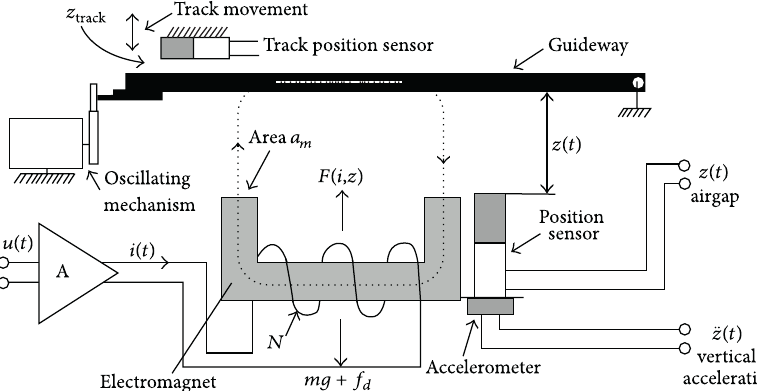
Figure 4: Vertical slice of magnetic levitation and rail in a magnetic train